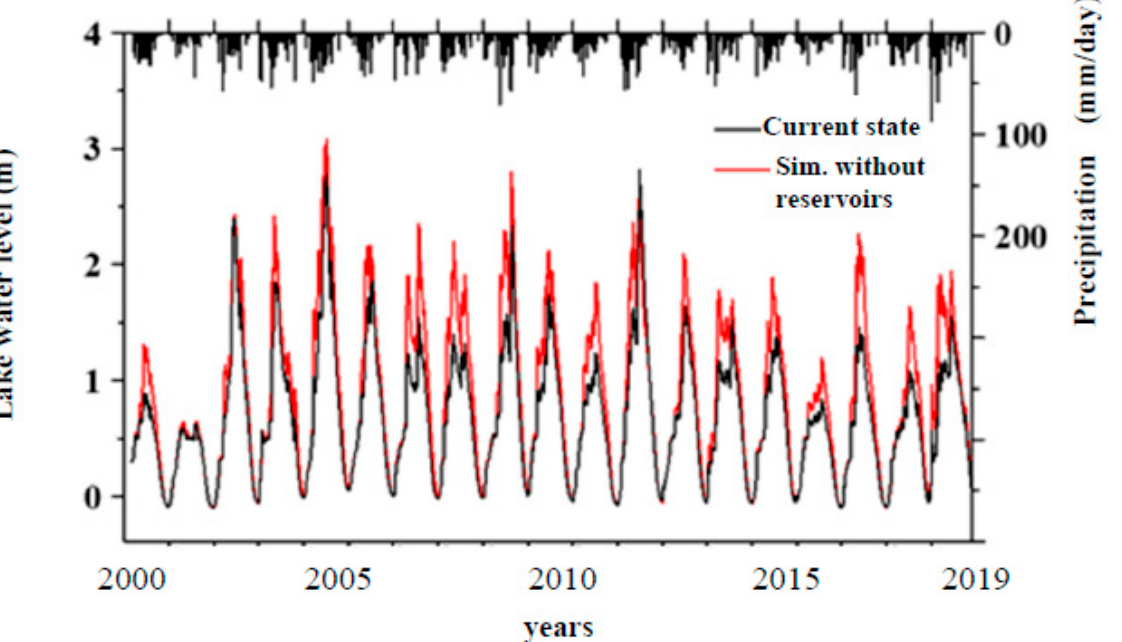
Figure 15. The simulations of the water level of the lake for 19 years (September 2000–2019). Table 4. Annual water budgets of the simulation without the reservoirs.